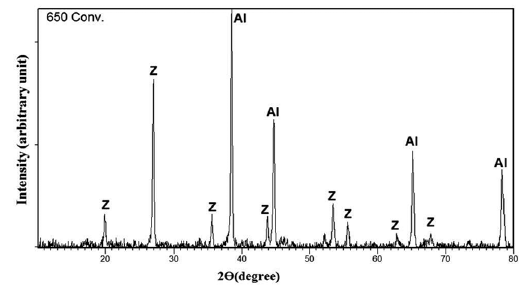
Figure 4: XRD of DC-650 composite sintered conventionally (Al: aluminum and Z: zircon).